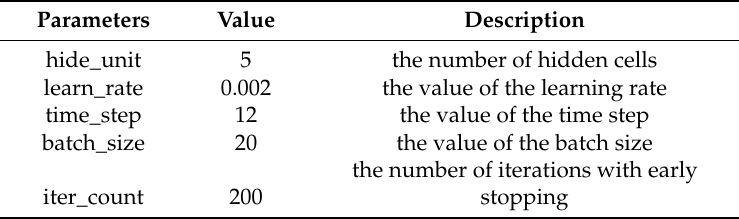
Table 6. Final parameter selection.